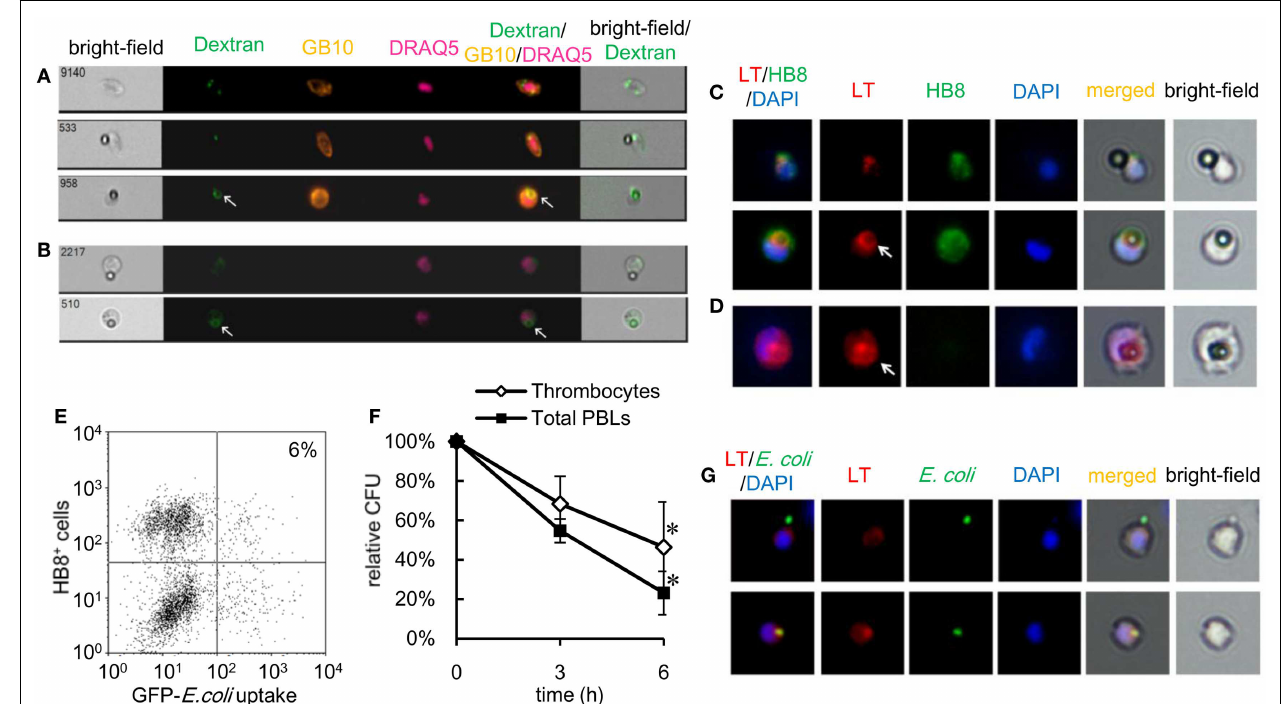
FIGURE 6 | Phagolysosome fusion and intracellular killing by thrombocytes and other leukocytes are shown . (A) Goldfish phagocytic thrombocytes stained with fluorescent dextran and incubated with non-fluorescent latex beads measuring 3 µ m in diameter for 3h at 25°C. Thrombocyte alone (upper), with bound (middle), or ingested (lower) beads. (B) GB10 mAb - goldfish phagocytes with bound beads (upper) and ingested beads (lower) and a phagolysosome ring (arrow). A phagolysosome ring is observed around the ingested particle (arrow). Dextran, FITC–dextran; GB10, mAb for goldfish thrombocytes; DRAQ5, nuclei. (C,D) Common carp phagocytic thrombocytes stained with LysoTracker Red to visualize acidic organelles. (C) Thrombocytes with bound (upper) or ingested (lower) non-fluorescent latex beads measuring 3 µ m in diameter. (D) Phagocytic mAb - leukocyte with an ingested bead (arrow).The phagolysosome ring as detected by acidic probe staining. LT (red), acidic organelles visualized by LysoTracker Red; HB8 (green), HB8 mAb specific for common carp thrombocytes; DAPI (blue), nuclei stained